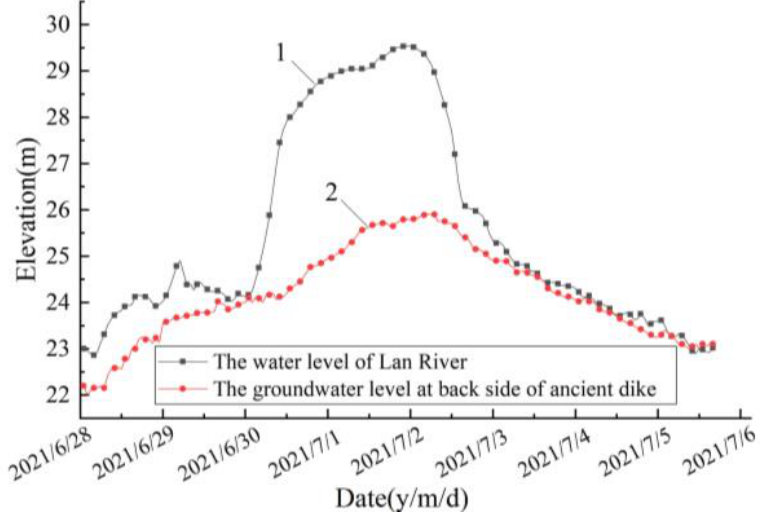
Figure 9. Water level boundary condition of numerical model.